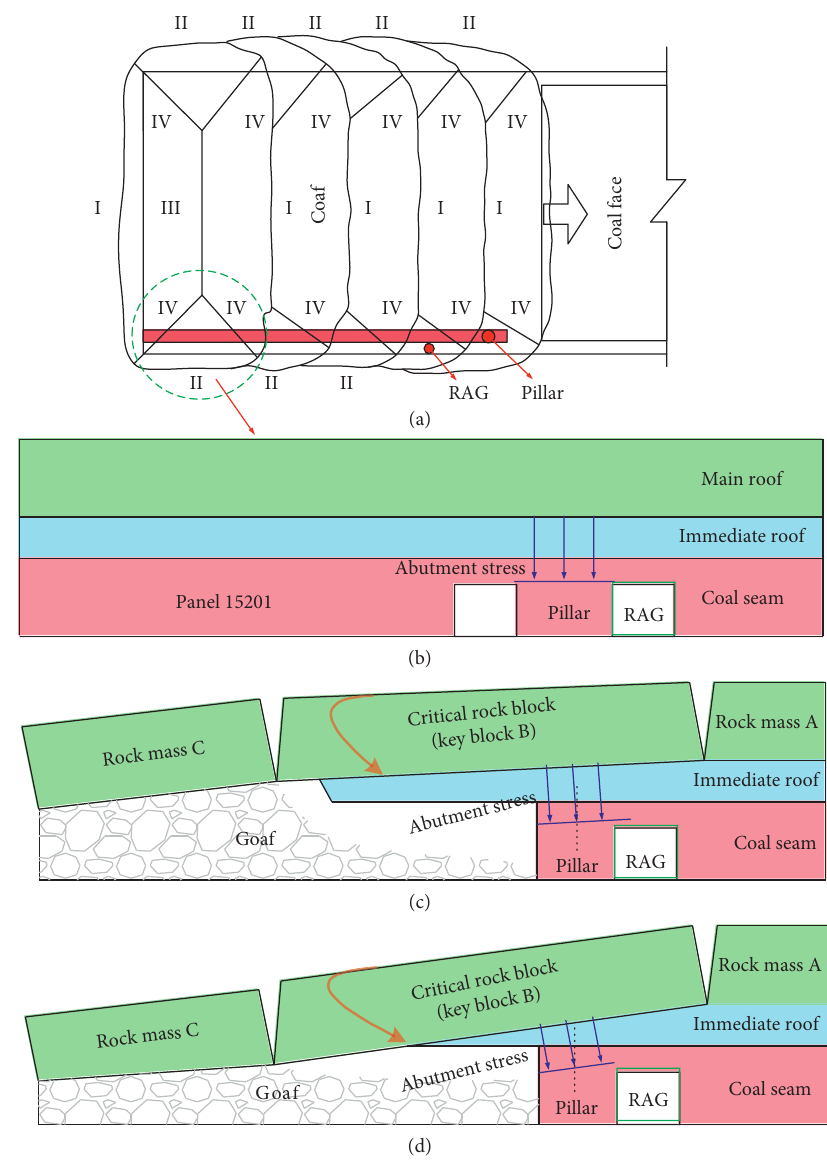
Figure 6: Failure characteristics of immediate roof above roadway adjacent to goaf (RAG) (negative and positive numbers indicate the 15201 longwall face was inby and outby the site, respectively). (a) O-X failure. (b) Stage A, − 10m. (c) Stage B, +80m. (d) Stage C +150